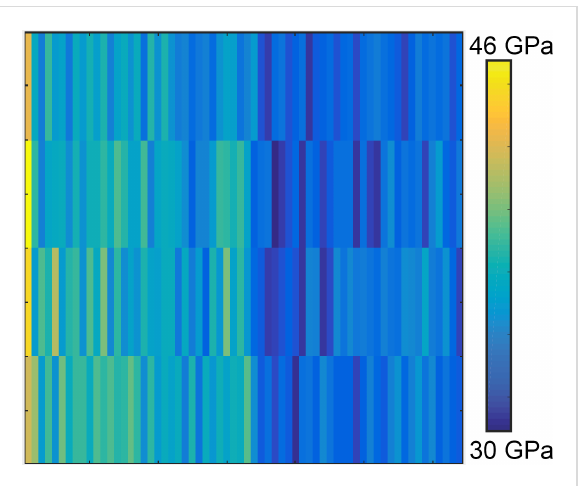
Figure 12 indicates a map of the elastic modulus over the graph- ite surface through static indentation. The static indentation has been conducted with a cantilever with stiffness of 38 N/m through a grid pattern over the HOPG surface. This elastic map is a combination of four rows and 64 columns, each comprising a forward and reverse force curve. The resolution of the map is not sufficiently high to see variations in the elastic